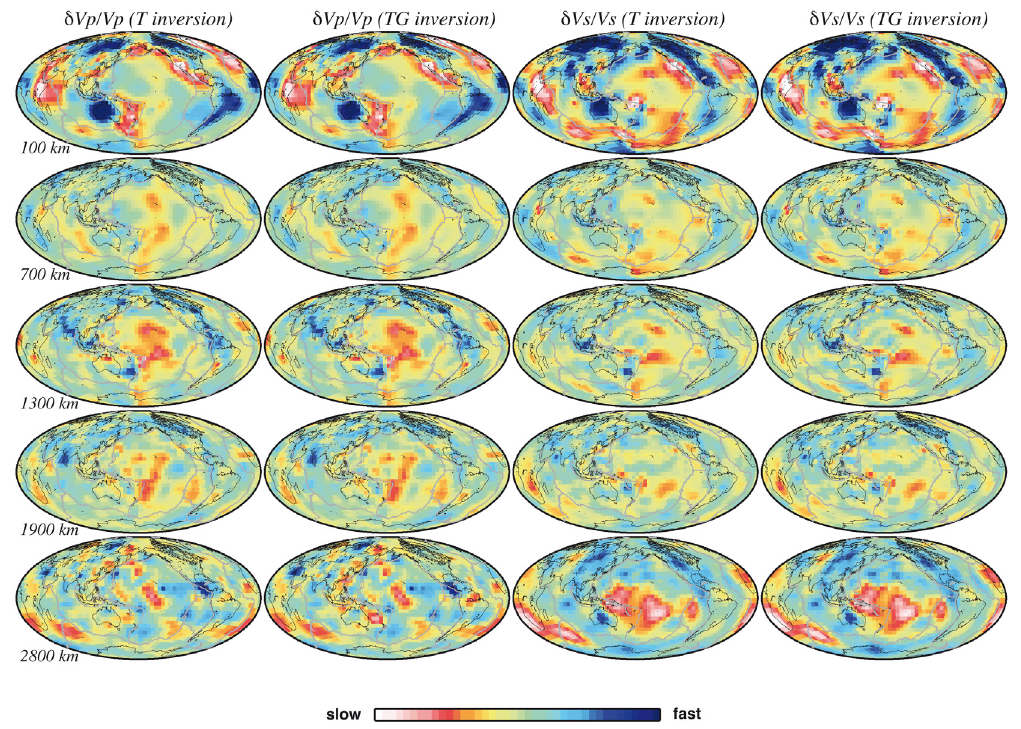
and y velocity variations (%) at (top to bottom) five different depths in the mantle, obtained from the entire Figure 1. Maps of relative y P S P , PcP , S data set. The maps are derived by jointly inverting ISC and Houser et al. (2008) data with a purely tomographic approach T (columns 1, 3), and with a tomographic-geodynamic approach TG (columns 2, 4). The scale for the dy maps is ±4% at 100 km depth and ±3% elsewhere; blue regions denote higher than average velocity, and red regions where, that for the dy S denote lower than average